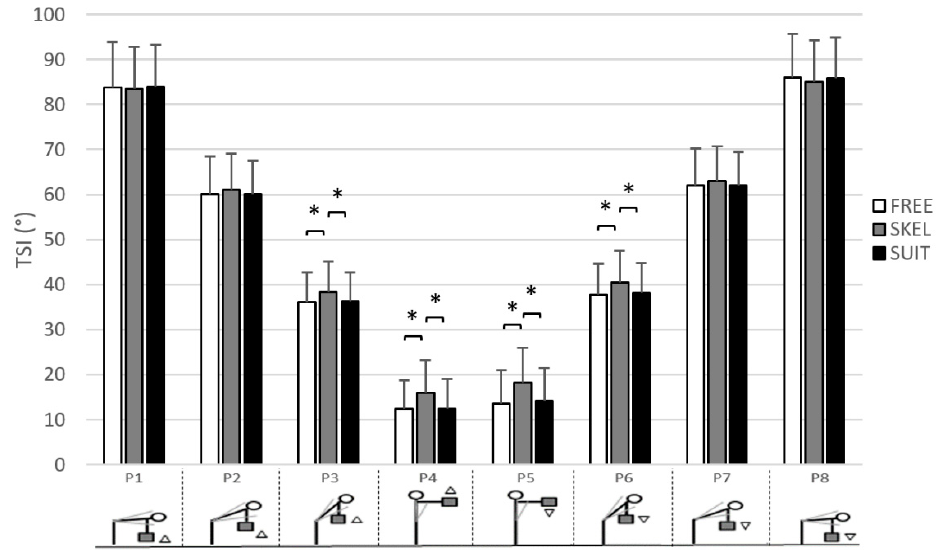
Figure 4. Averaged trunk sagittal inclination (TSI, in °) and standard deviation for each TSI part (from P1 to P8) of the lifting/lowering task (LLT) with the rigid exoskeleton (SKEL, gray), the exosuit (SUIT, black), and without equipment (FREE, white). 0° = straight posture. *: significant differences between exoskeletons ( p < 0.05).